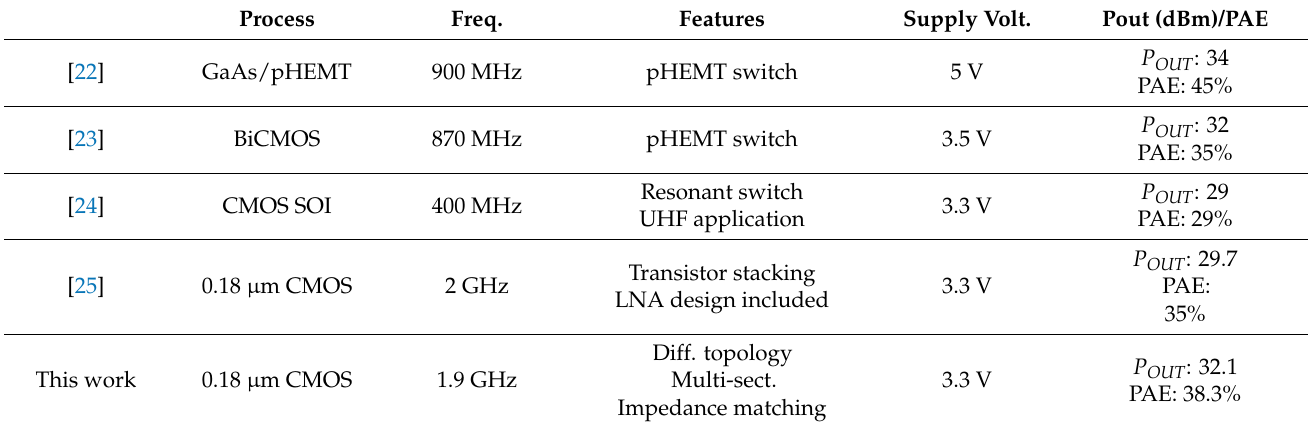
Table 1. Transmitter front-end performance